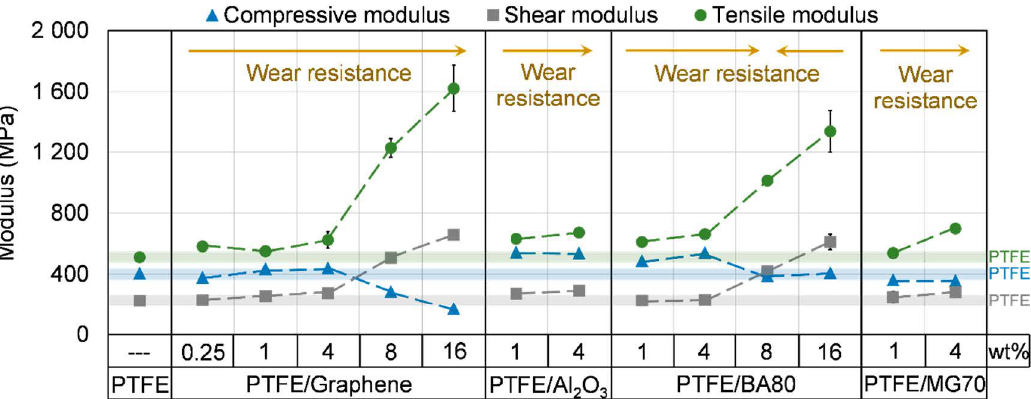
Figure 7. Compressive, shear and tensile stress of unfilled and filled PTFE samples at 5% strain. The blue, grey and green transparent lines display the compressive, shear and tensile stress of neat PTFE, respectively.